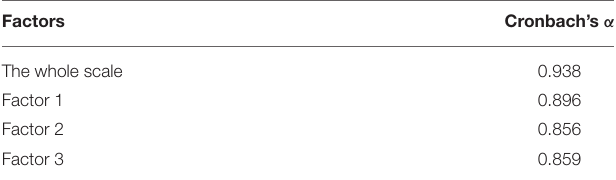
TABLE 4 | Reliability analysis of the Gaming Hazard Assessment Scale in three dimensions (sample 1, n =